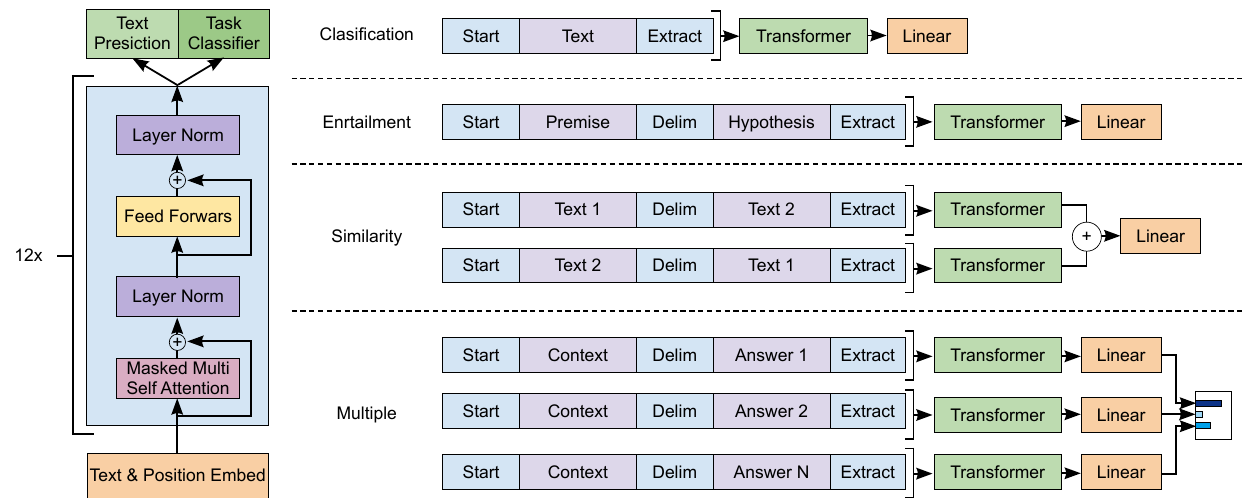
Figure 2 GPT-1 Model Structure. Perform the pre-training through the Transformer structure on the left, and then fine-tune through the linear and softmax layer structures according to different types of downstream tasks on the right. One disadvantage of this structure is that all downstream tasks require fine- tuning, which increases a lot of work during the use of the model [13].